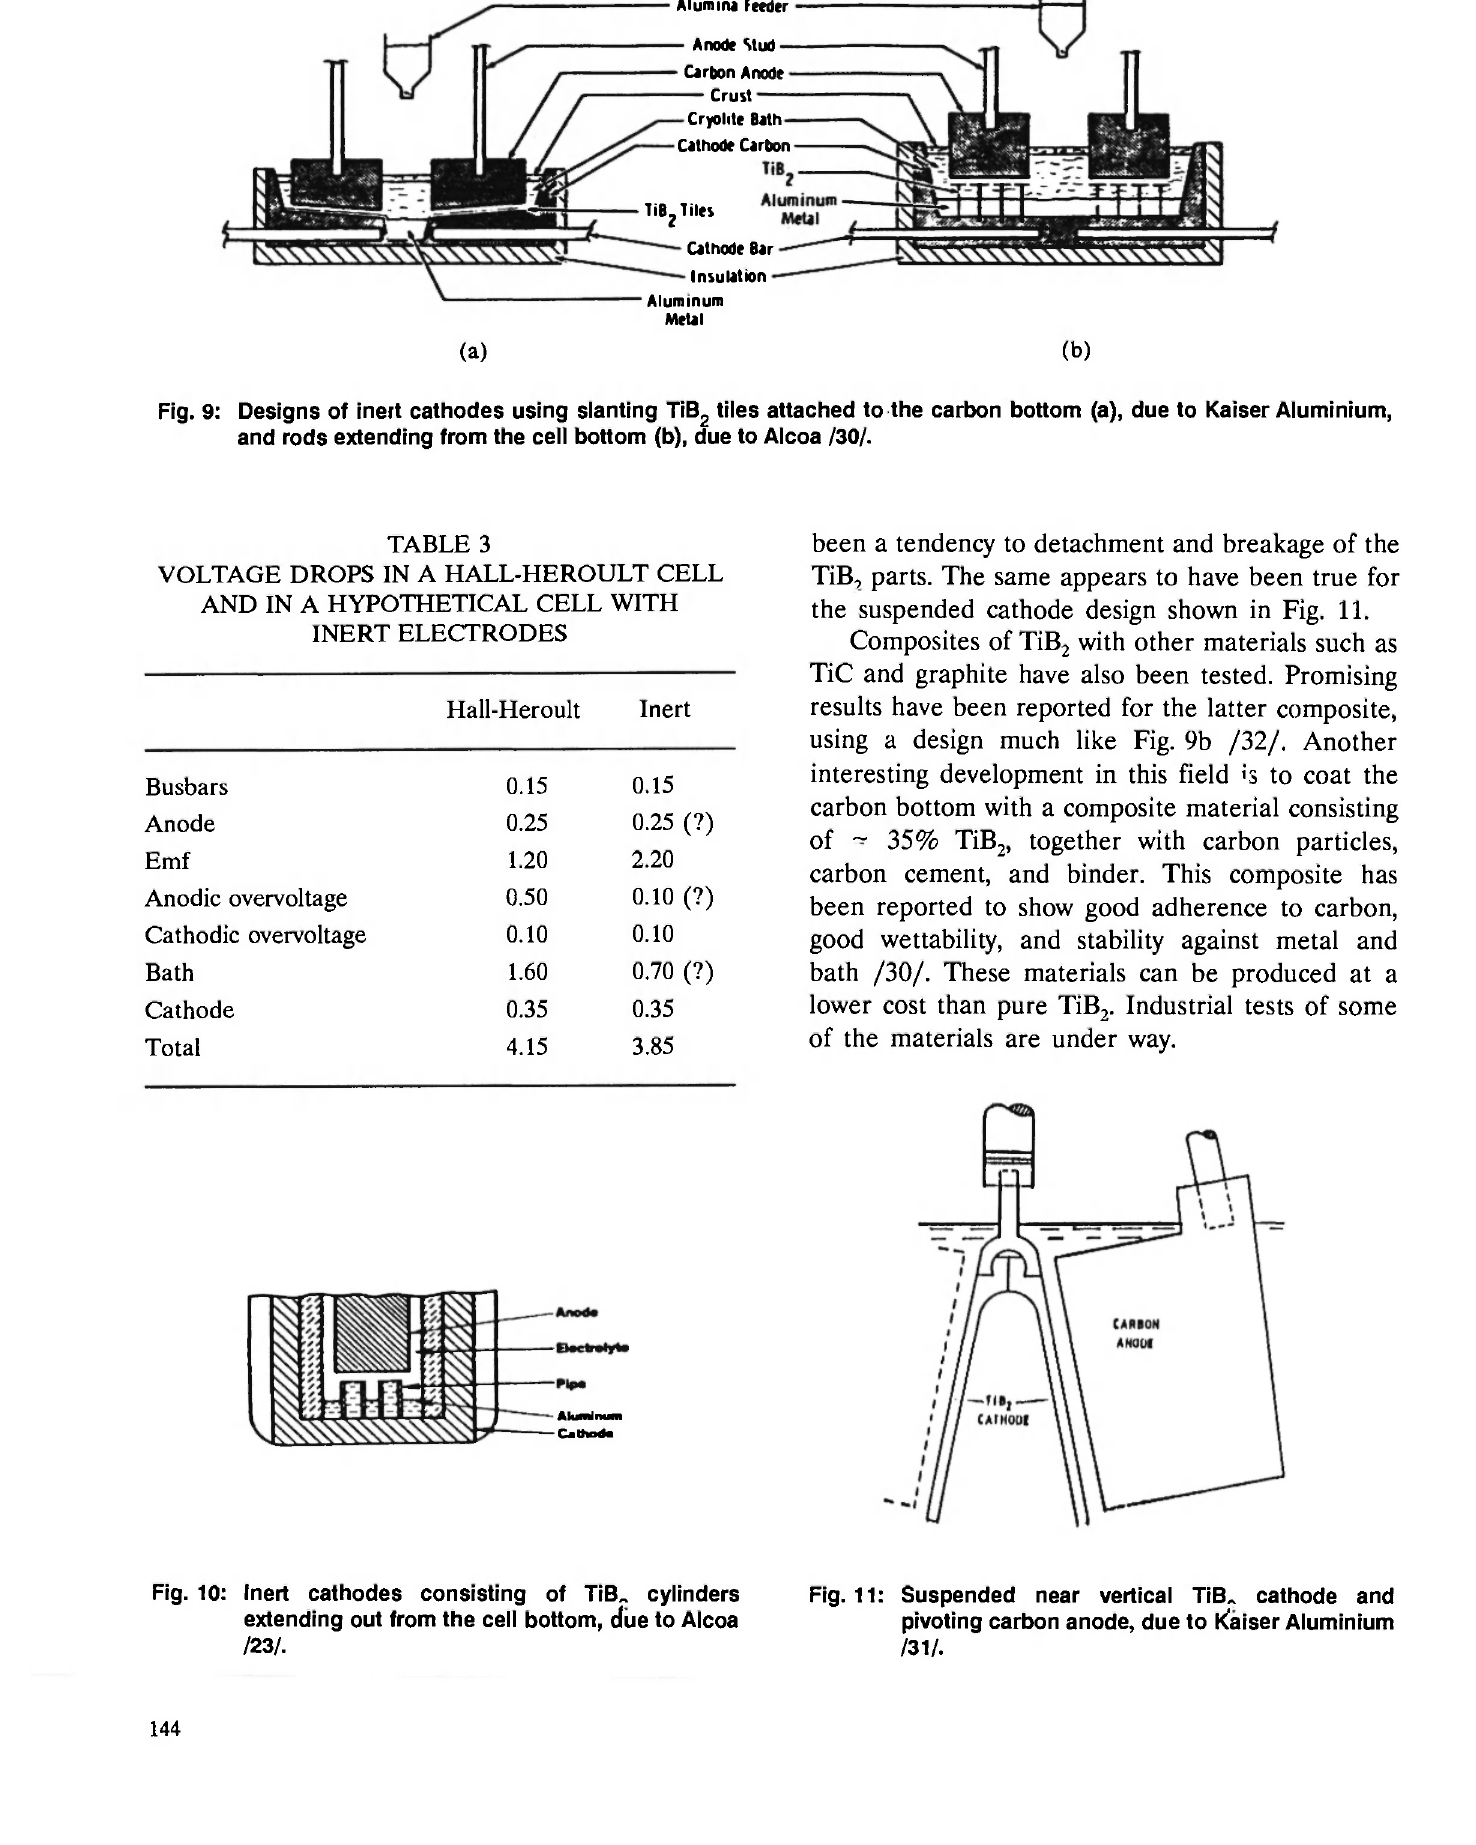
Fig. 11: Suspended near vertical TiBL cathode and pivoting carbon anode, due to kaiser Aluminium